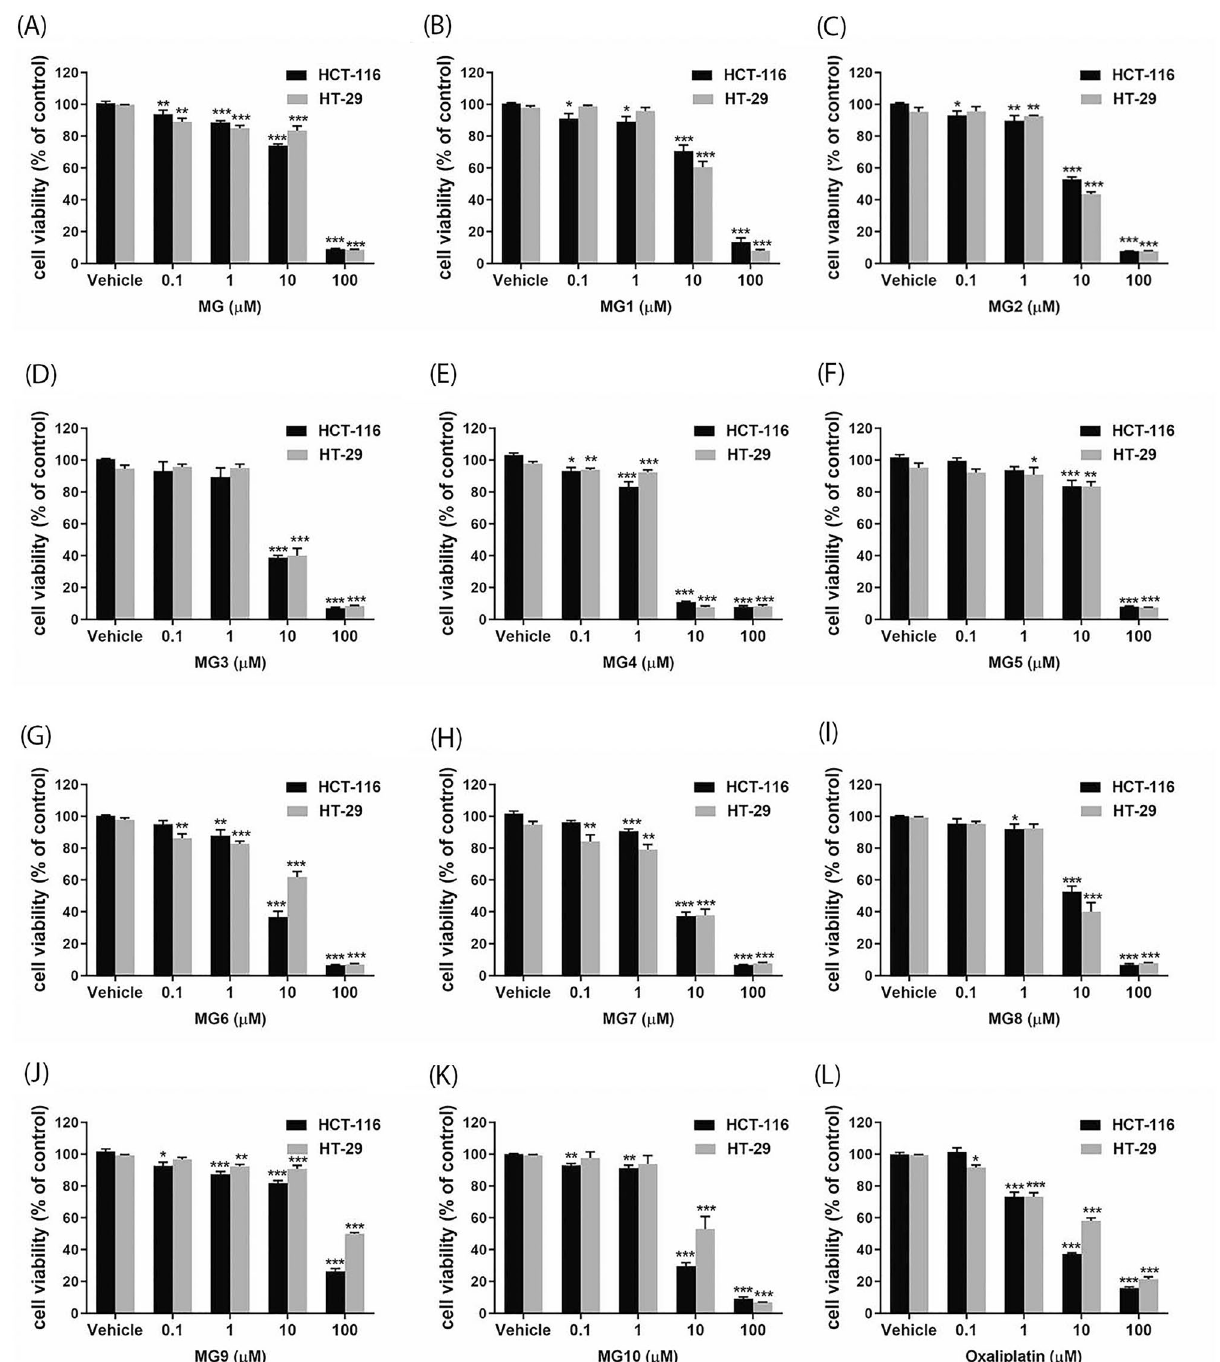
Figure 2. Effects of MG and its derivatives on viability of ( A ) HCT-116 and ( B ) HT-29 cells. The cells were treated with MG, semi-synthesized derivative of MGs or oxaliplatin at 0.1, 1, 10, and 100 µM for 48 h.